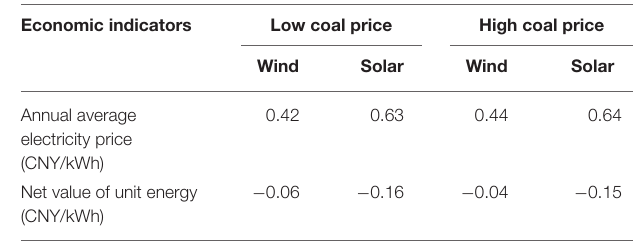
TABLE 3 | Economic value of wind and solar power generation in guangdong province under the market